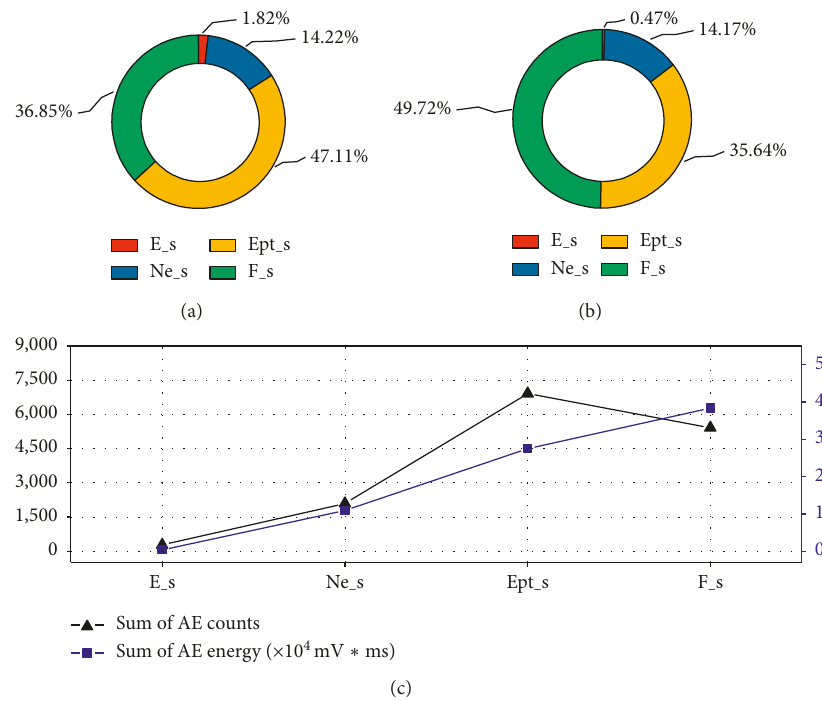
Figure 15: Trends in AE event counts and energy counts of C40-C10-C40 concrete block and their respective percentages (legends as per Figure